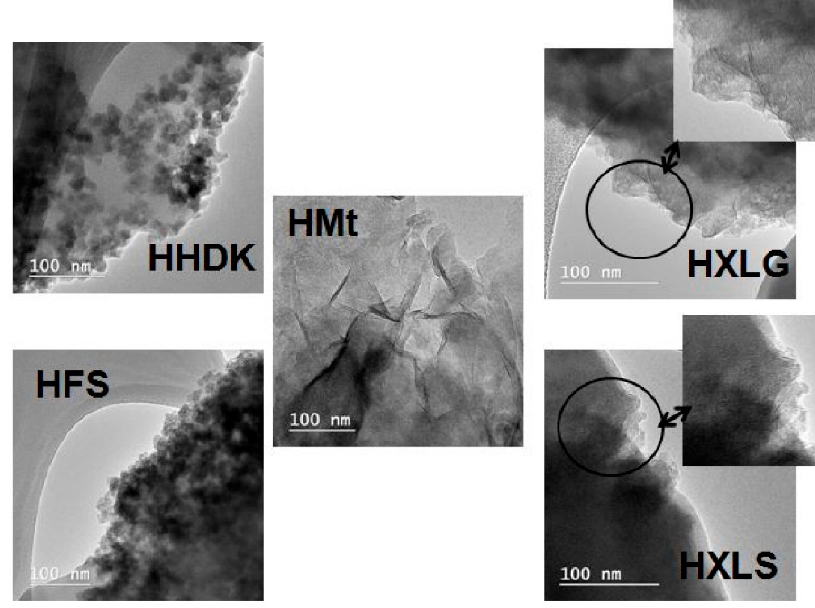
Figure 3. TEM images for hydrogels reinforced with various reinforcing agents.